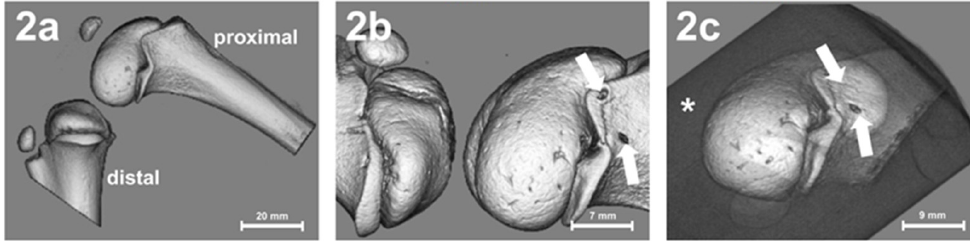
Figure 2. Micro-CT imaging of the left knee joint: ( a ) before ablation, ( b ) after ablation, and ( c ) after embedding in synthetic resin ( * ). Two ablation lesions (marked by white arrows). Error bars with units in mm.